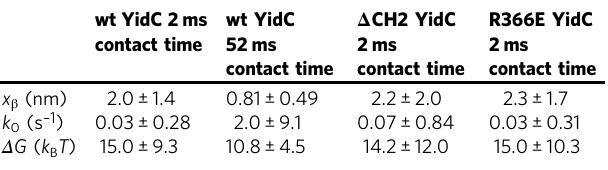
x β and k 0 were extracted by fi tting the DFS plots with the Bell-Evans model (Fig. 5a – d). Δ G was calculated using the Arrhenius equation (Methods). Errors in x β and k 0 describe 95% CI, while errors in Δ G were calculated by propagating errors in k 0 .